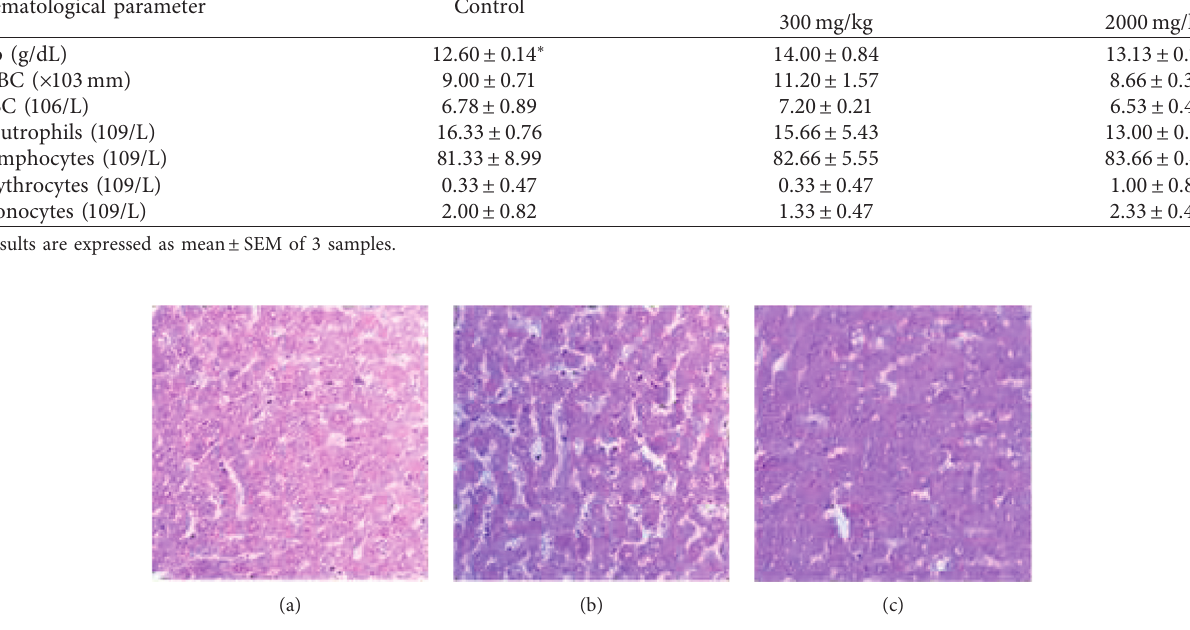
Figure 5: Photomicrographs of liver sections of rat. (a) Control. (b) A. malaccensis 300mg/kg. (c) A. malaccensis 2000mg/kg. Scale bar, 10 µ m.